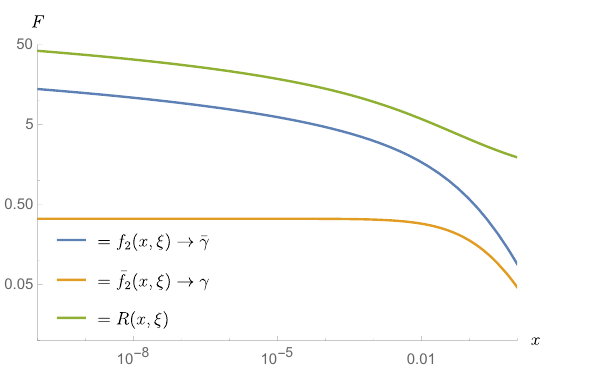
, and the loop (cid:22) f 2 ( x(cid:24) )